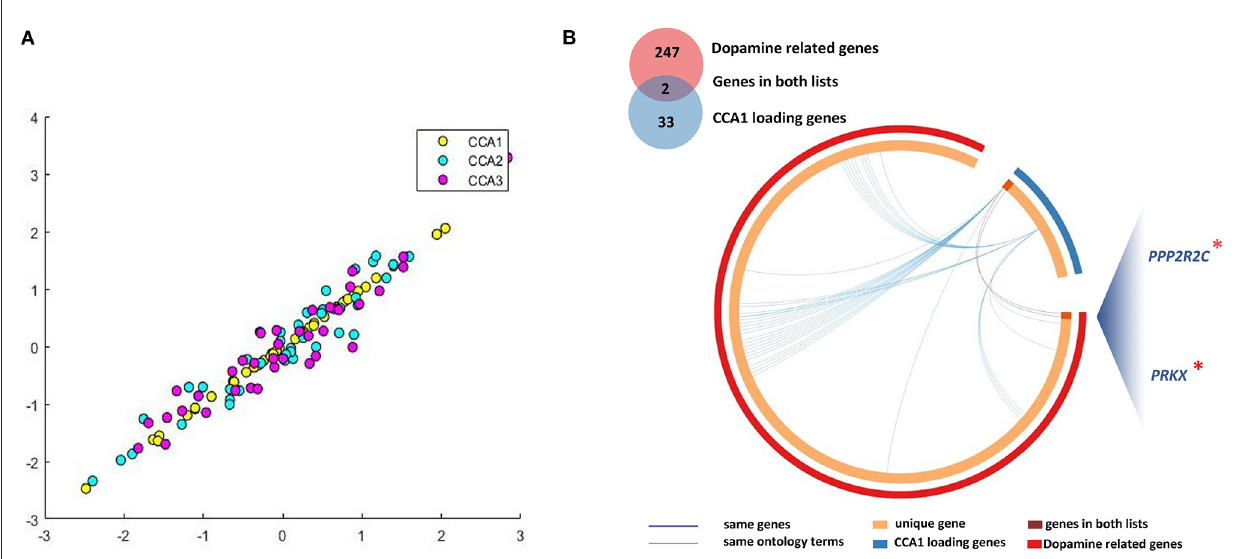
FIGURE3 Multivariate correlations between DNAm of CCA loading genes and clinical symptoms. (A) We identified significant CCA1 loading genes (33 representative features) associated with patients’ longitudinal alterations of clinical symptoms; (B) There are two overlapping genes of 33 CCA loading genes and the 247 dopamine-related genes. CCA, canonical correlation analysis. *, important genes overlapping between dopamine related genes and CCA1 loading genes.